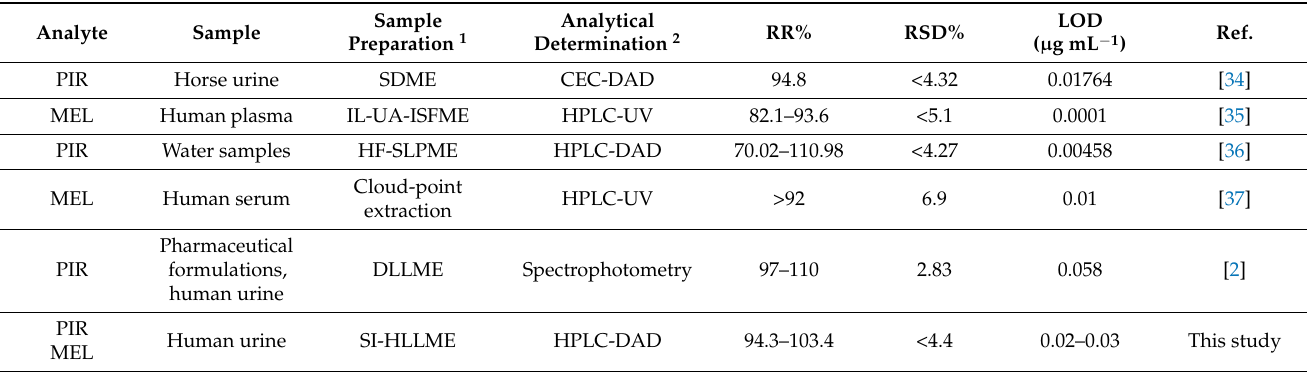
Table 4. Comparison of the SI-HLLME method with other microextraction